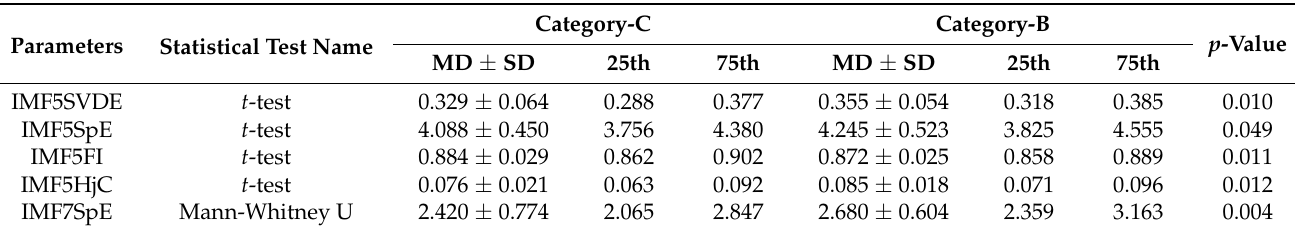
Table 1. Characteristics of statistically important IMF-derived parameters.